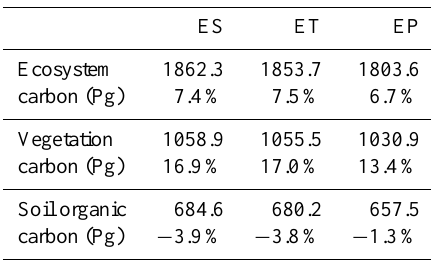
Table 3. Predicted total carbon in pools at the end of the future simulation (year 2100) and percentage increase in each carbon pool over the simulation